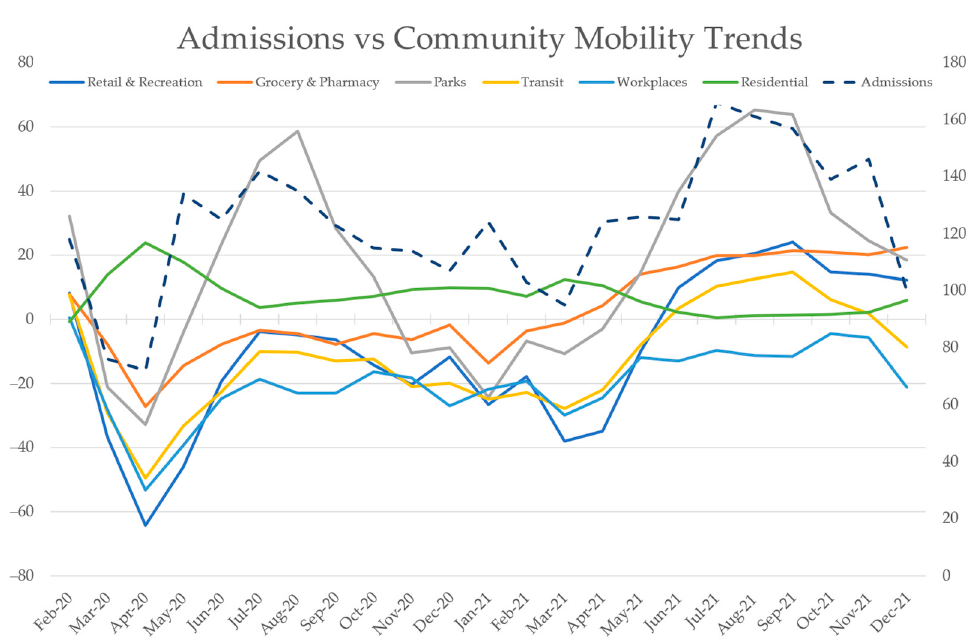
Figure 1. Total monthly psychiatric admissions (right axis, represented with the dashed line) charted against mean monthly community mobility (left axis, measured in percentage changes from baseline).